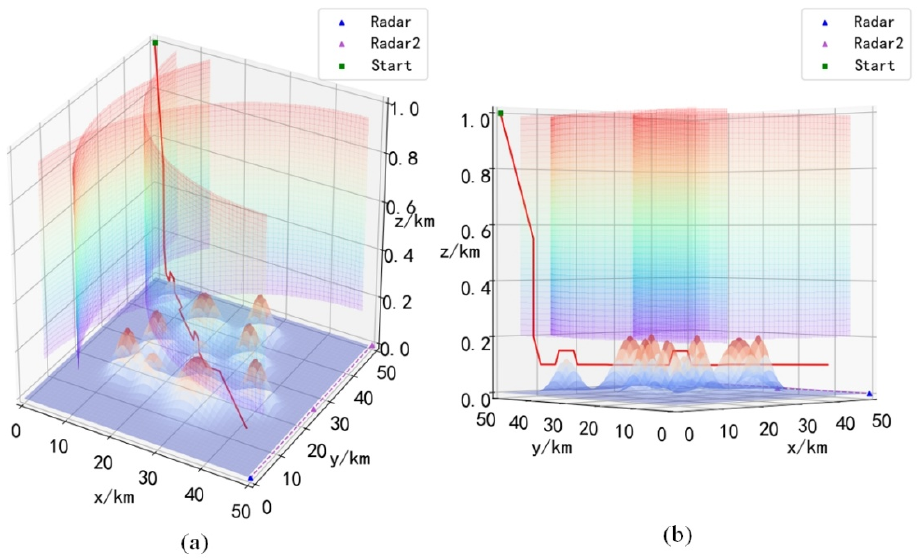
Figure 16. The path planning result in scenario 5. ( a ) is the full view of the path, ( b ) is the side view of the path. The purple dotted line is the trajectory of the vehicle radar, and we have drawn its radar detection boundary at three special positions [50,50,0] , [50,25,0] and [50,0,0] .